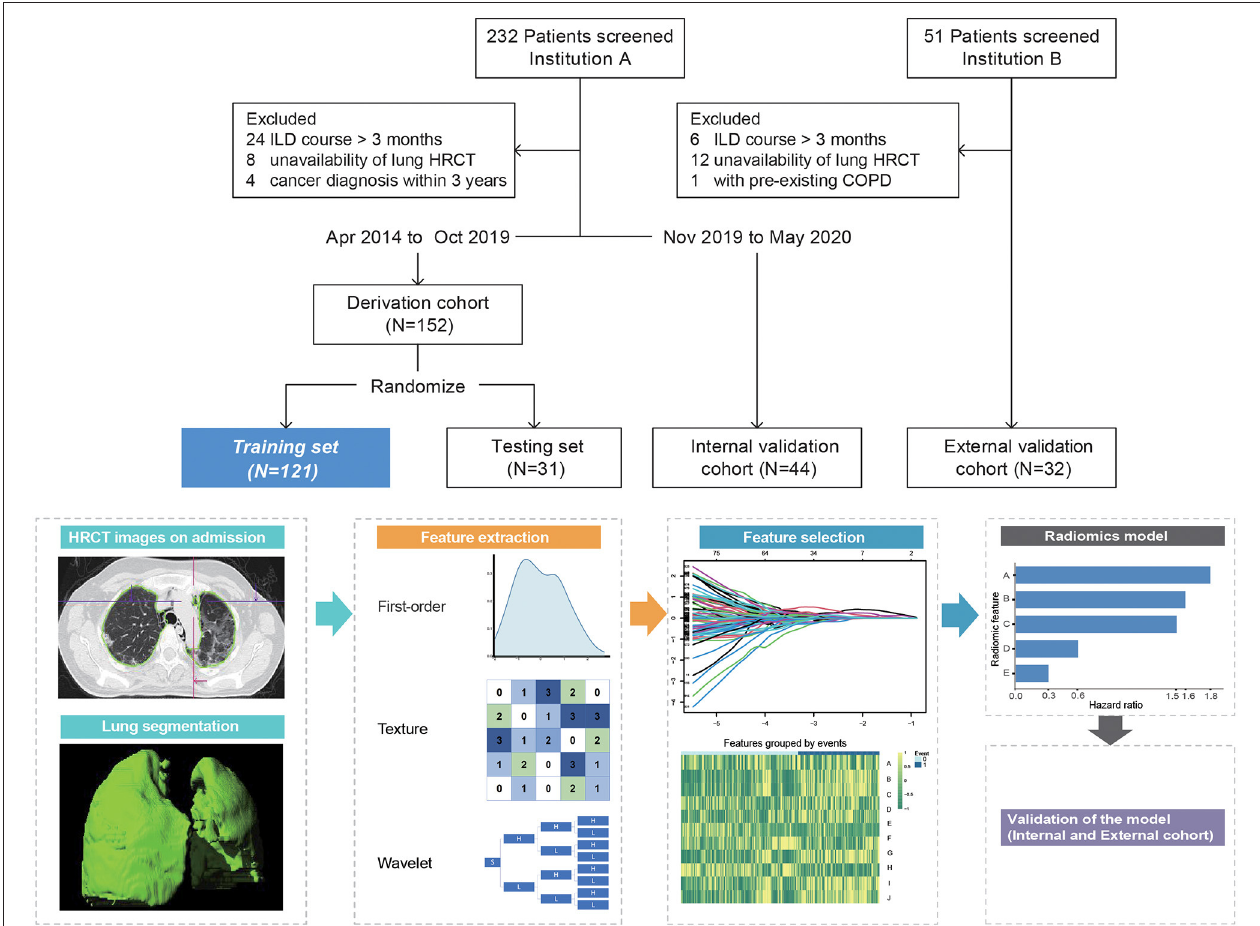
FIGURE 1 | Overview of patient selection and workflow of radiomics model construction. Radiomic feature A = Original_Shape_Flatness (HR 1.82, 95%CI 1.28–2.59, p < 0.001), B = Wavelet.LLL_Glcm_MCC (HR 1.59, 95%CI 0.97–2.6, p = 0.068), C = Wavelet.LLH_Glcm_Ldmn (HR 1.5, 95%CI 1.02–2.22, p = 0.04), D = Wavelet.HLL_Glszm_LargeAreaHighGrayLevelEmphasis (HR 0.58, 95%CI 0.38–0.89, p < 0.001), and E = Wavelet.LLL_Firstorder_Skewness (HR 0.30, 95%CI 0.18–0.52, p < 0.001). ILD course, time from the first abnormal pulmonary CT that revealed ILD changes to admission; HRCT, high-resolution computed tomography; COPD, chronic obstructive pulmonary